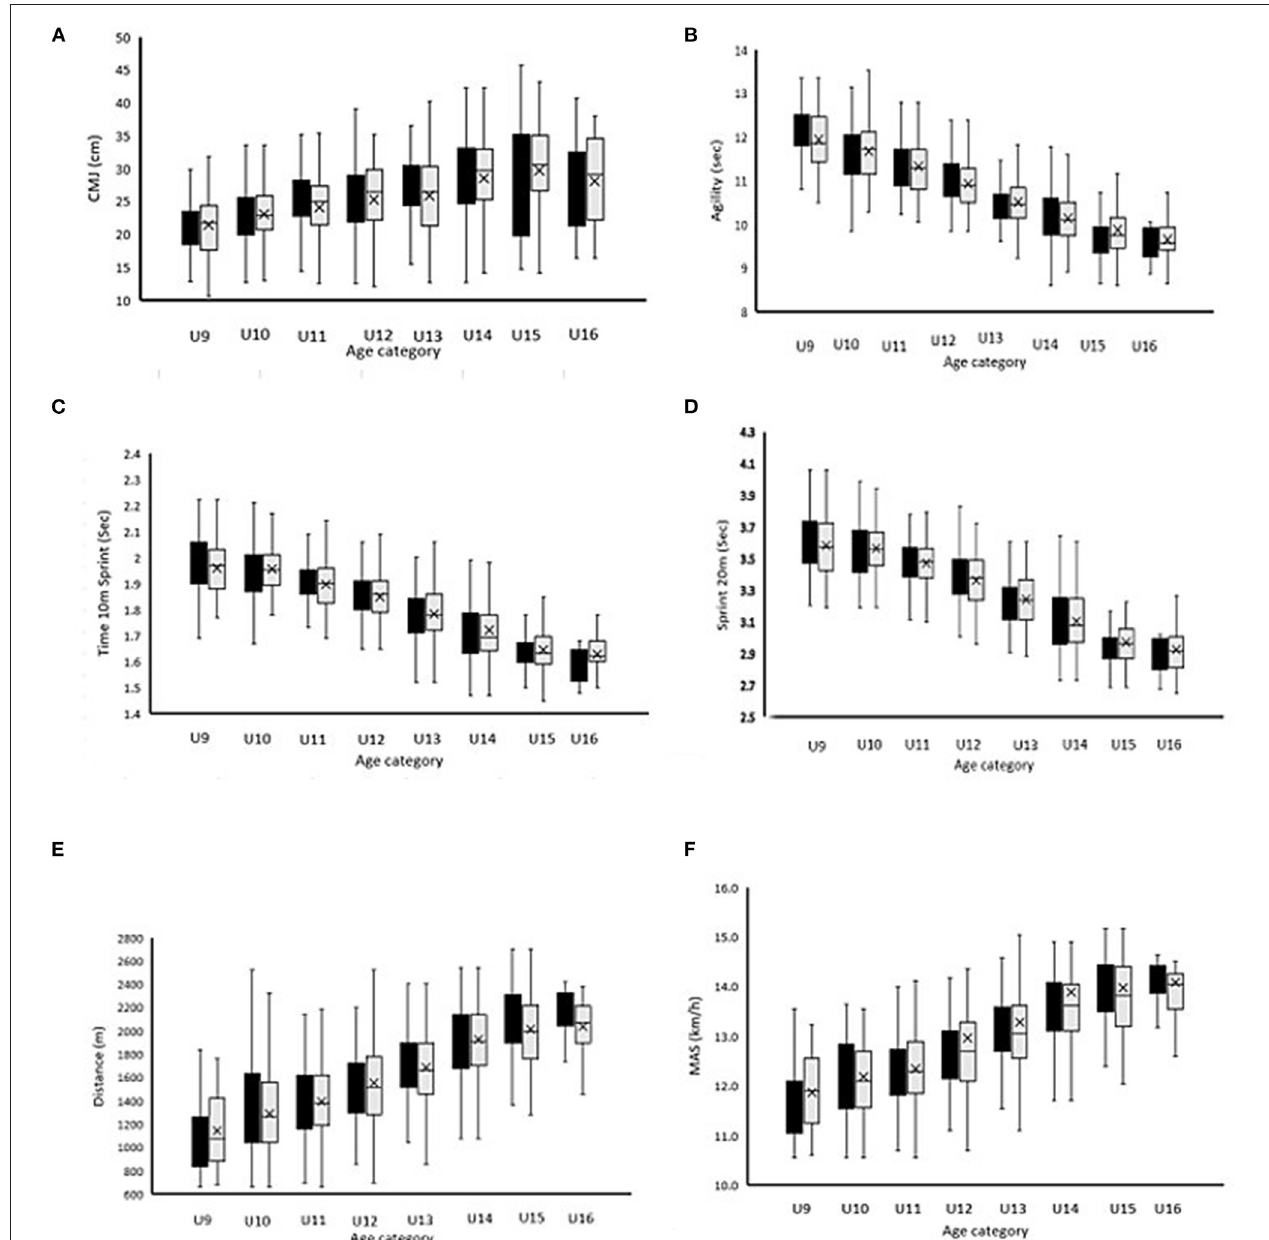
FIGURE 7 | Mean ± SD for physical [ (A) CMJ; (B) Agility; (C) 10m sprint; (D) 20m sprint; (E) Distance MSFT; (F) MAS MSFT] characteristics of 812 UK academic soccer players according to the traditional categorization based on chronological age (black bars) vs. the newly proposed reallocation method (gray bars). CMJ, counter movement jump; MSFT, multi-stage fitness test; MAS, maximal aerobic